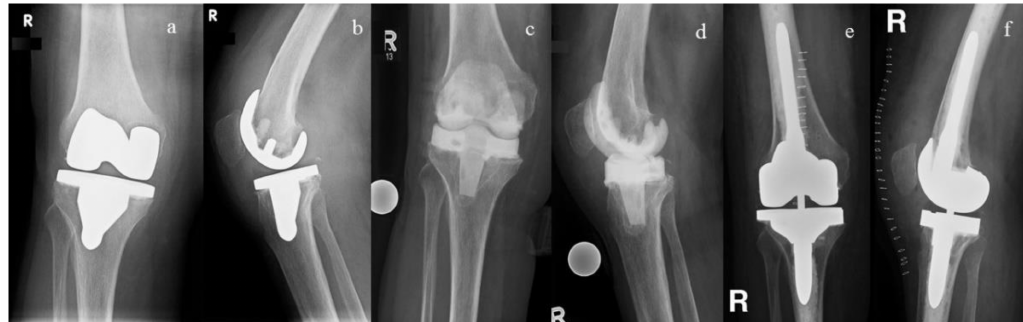
Figure 4. ( a , b ) Anterio-posterior ( a ) and lateral ( b ) radiographs of the right knee of a 69-year-old woman with a septic loos- ening of the tibial component; ( c , d ) After prosthesis explantation, an articulating spacer was implanted; ( e , f ) Following an interim period of 54 days, a condylar-constrained prosthesis was implanted (Triathlon TS ® , Fa. Stryker, Duisburg, Germany).